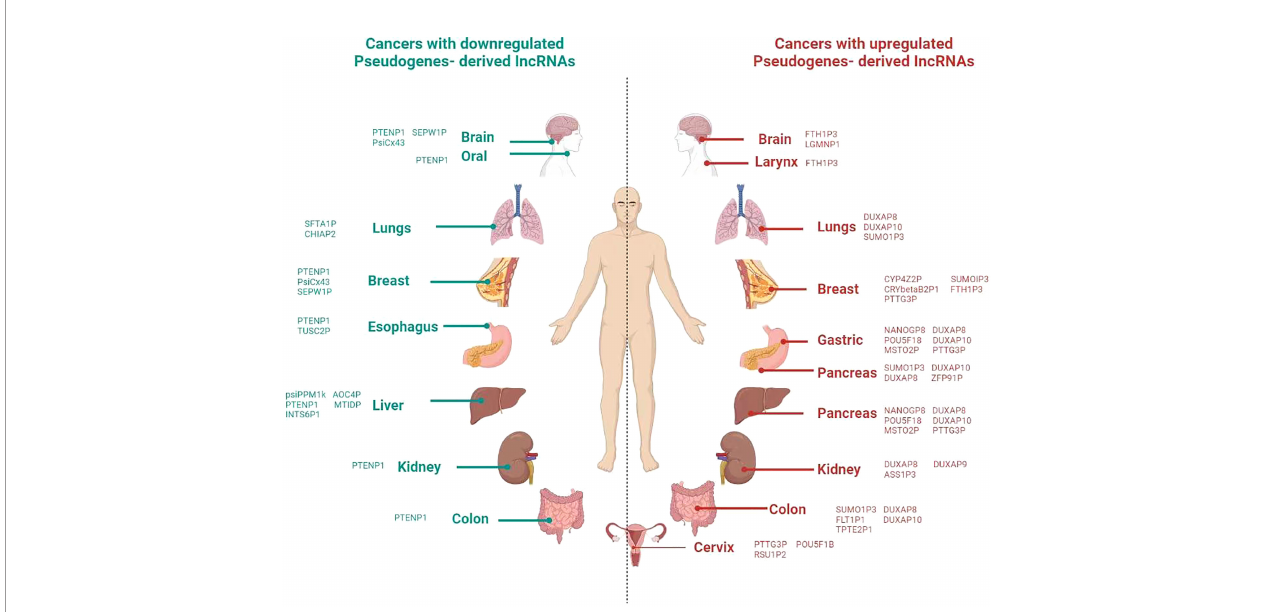
FIGURE 2 | Overview of involvement of pseudogene in different cancer in the human body. Icons of body parts for the refrence are taken from different